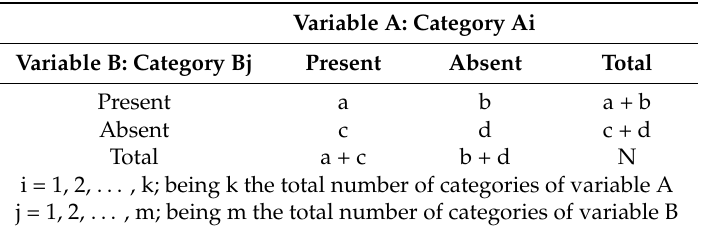
Table 1. Example of contingency